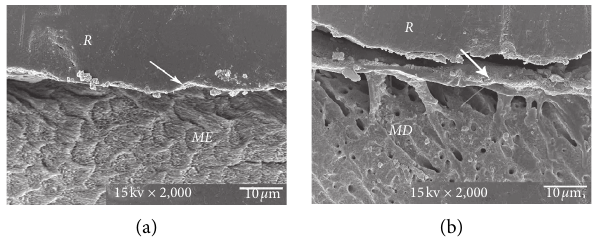
Figure 6: SEM micrograph of All-Bond 2-restored resin-composite after chemical challenge, demonstrating the detached and degraded interfacial layer (arrowed) in the enamel (a) and dentin (b) (original × 2,000, ME � modified enamel, MD � modified dentin, and R �